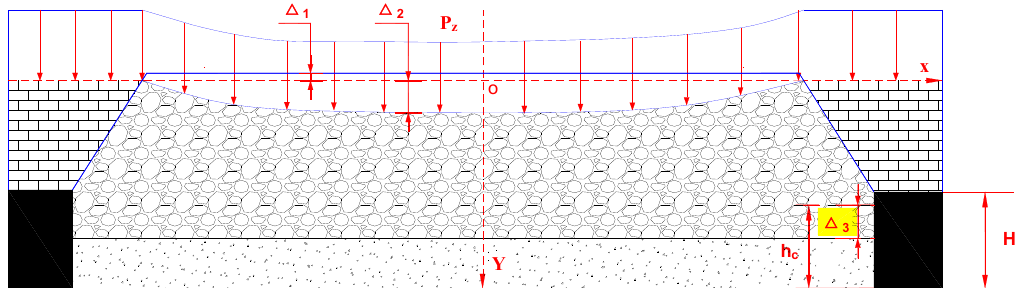
Figure 2. Mechanical model diagram for PCFM.